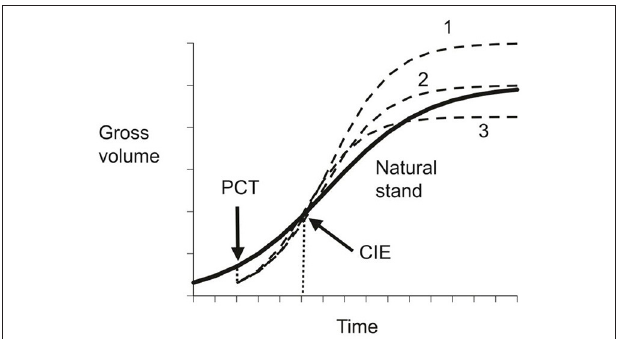
FIGURE 1 | Schematic illustration of compensatory growth. The solid line represents gross volume in natural stands, the dished lines indicates possible compensatory outcomes under different precommercial thinning regimes: 1 – over-compensation; 2 – exact compensation; and 3 –